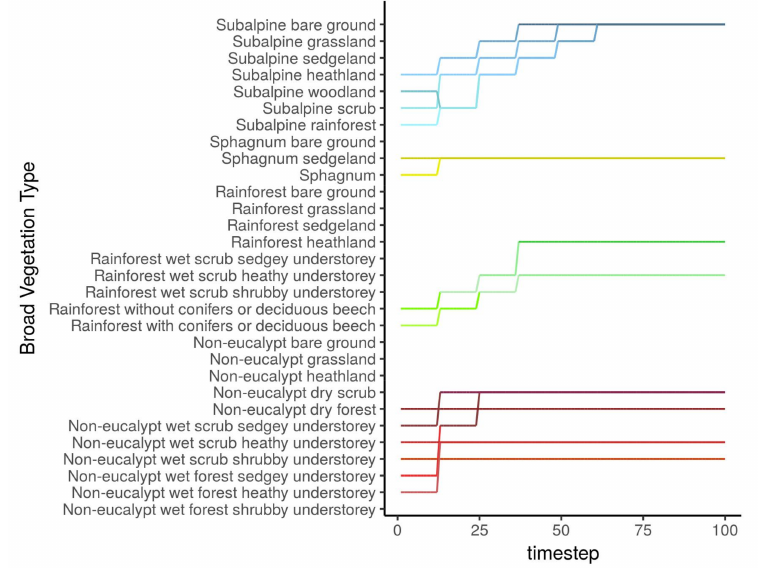
Figure 6. The impact of a ten-year fire interval on vegetation types across Tasmania over a period of 100 years, beginning in 2000. Transitions were constrained along vegetation pathways, indicated by different colors, with each type having different tolerances to fire